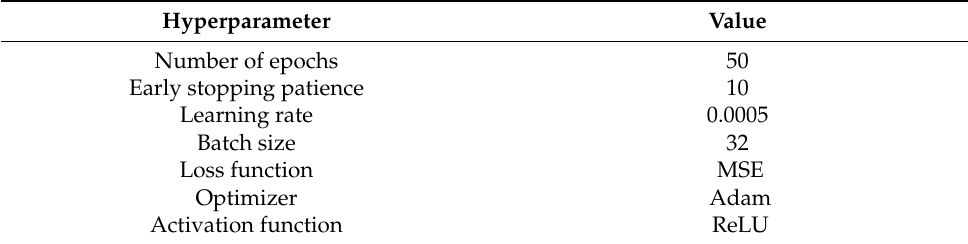
Table 2. Hyperparameter setting for the benchmark